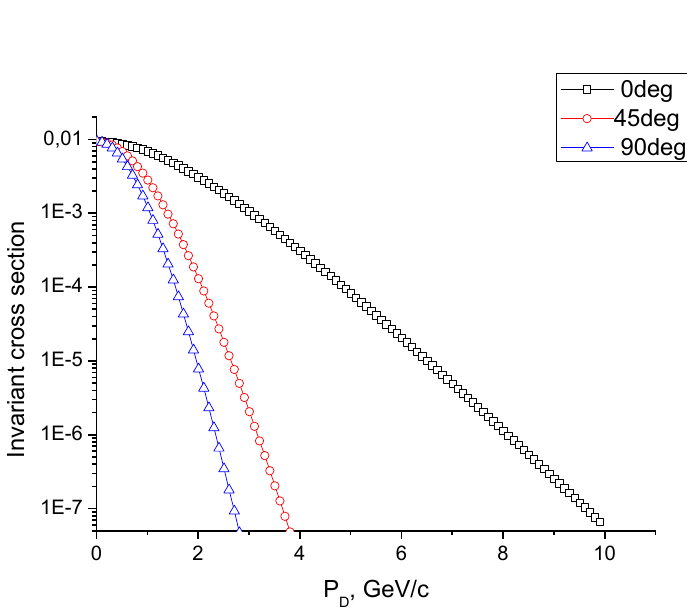
Figure 3. Invariant cross section (mb·GeV -2 ·c 3 ·sr -1 ) of the D+D- production in Au-Au collisions at 4 GeV/c for 0, 45, and 90º